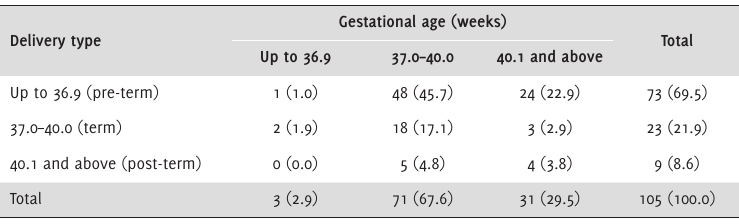
Table 2. Delivery Types and Gestational Age